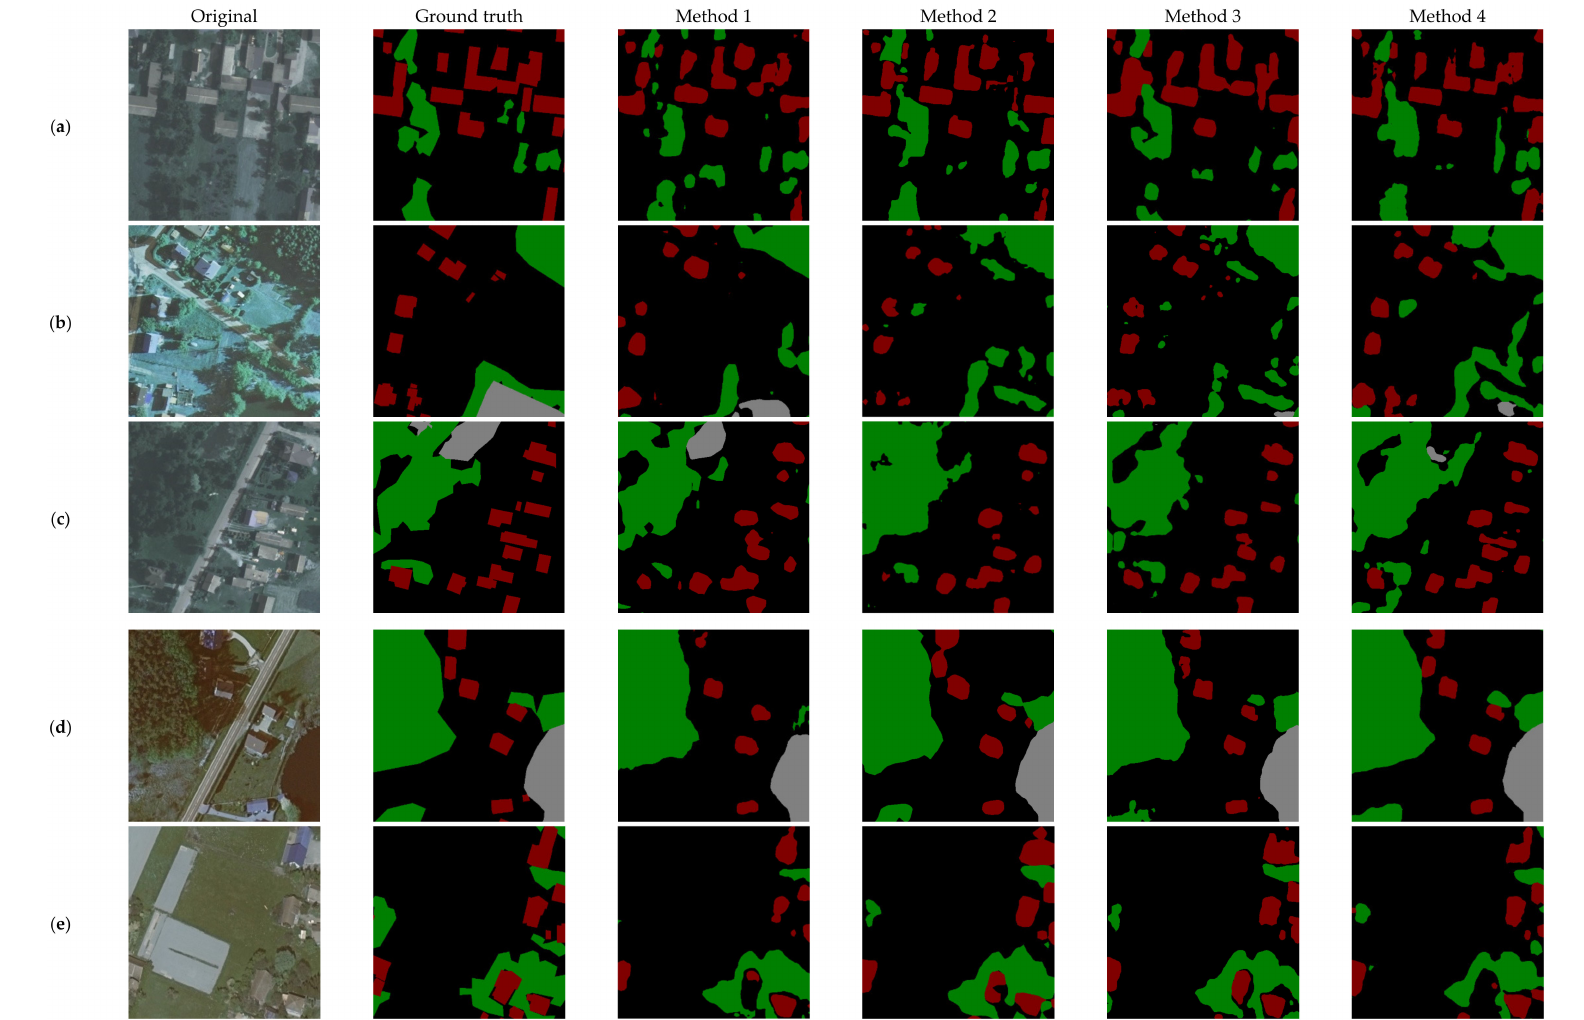
Figure 5. Local prediction of 1–4 sampling methods in the LandCover dataset, the meaning of colors is buildings (red), woodlands (green), water (grey), and backgrounds (black). ( a – e ) are the experimental results of 1–4 methods on images from the LandCover